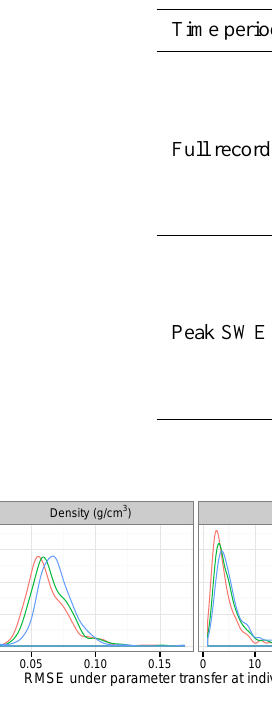
Fig. 7. Distribution of RMSE in density and SWE at individual SNOTEL